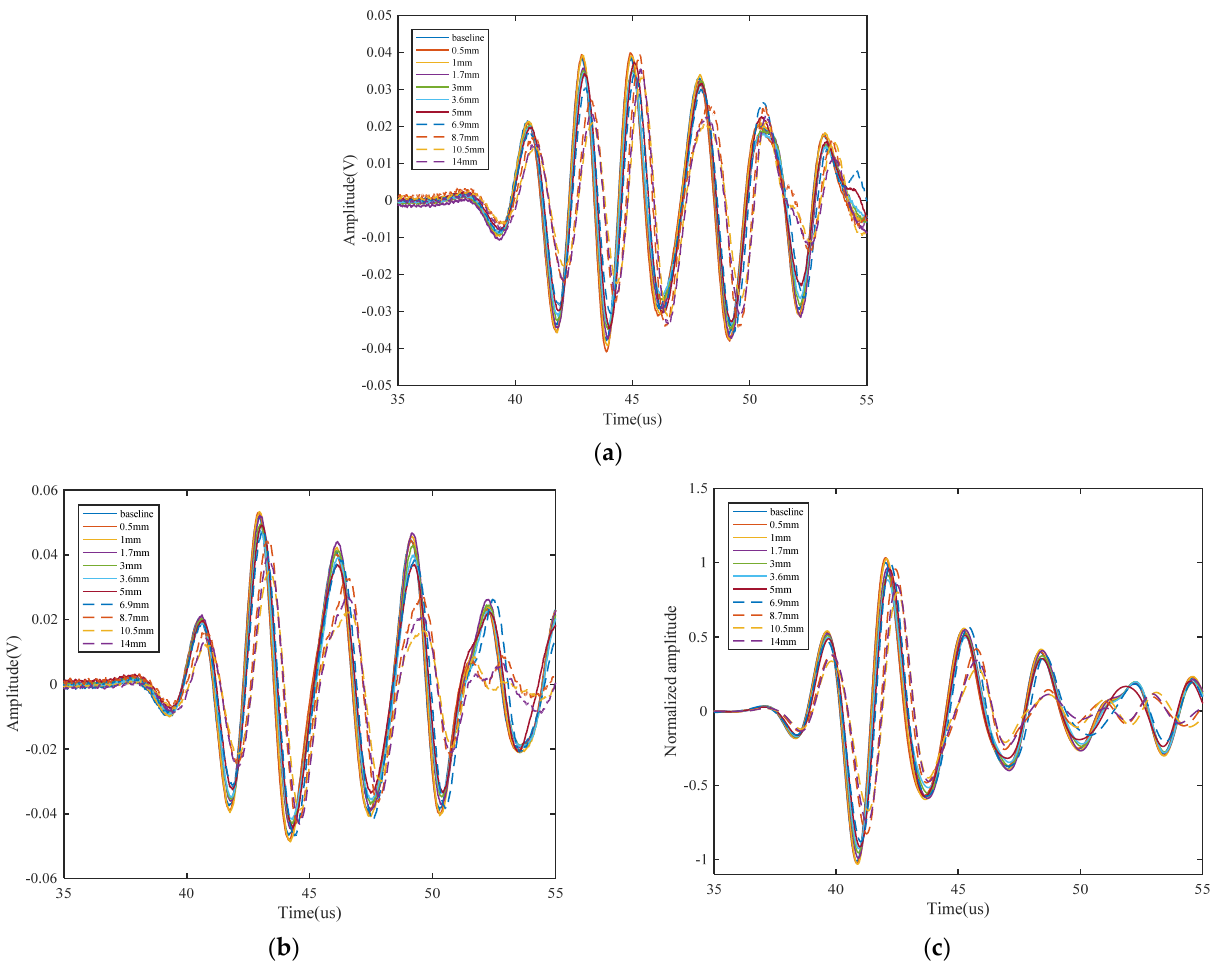
Figure 18. Received waveform of 500 kHz GCC signal: ( a ) raw signal of sequence A; ( b ) raw signal of sequence B; ( c ) the signal processed by dispersion compensation and pulse compression techniques.